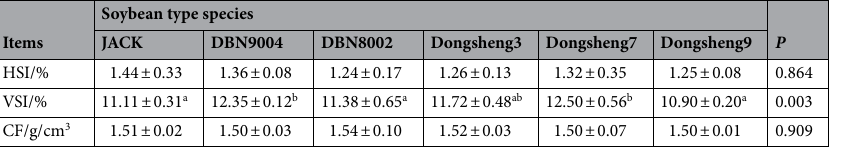
Table 4. The effects on the body index of channel catfish fed transgenic soybeans (n = 25). HSI, Hepatosomatic index; VSI, viscerosomatic index; CF, condition factor. p < 0.05 indicates significant differences among the six experimental